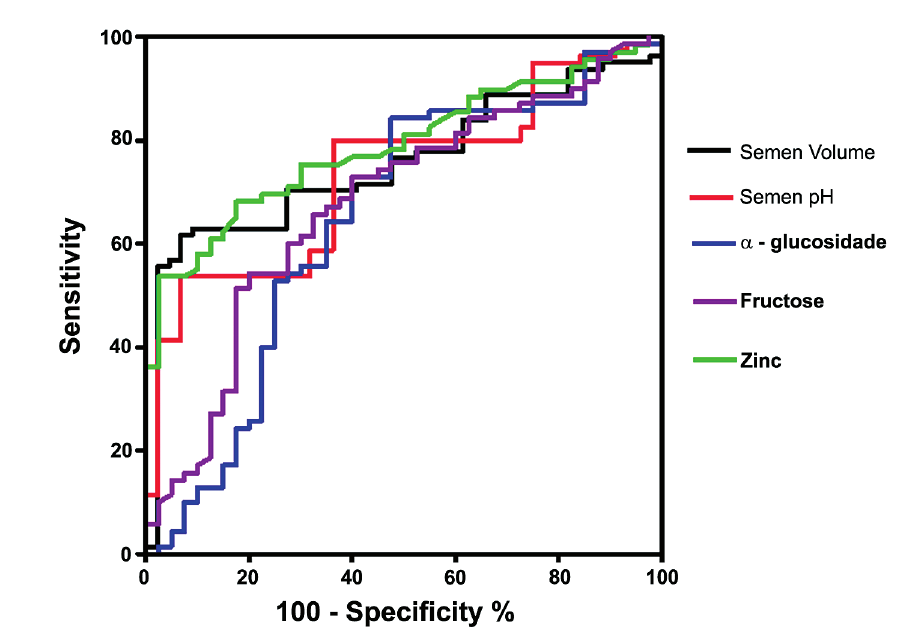
Figure 1 – ROCC analysis of semen volume, semen pH, alpha-glucosidase, fructose and zinc levels, to differentiate men with vs. without MRT infection. Semen volume = cut point 2.75 mL; sensitivity = 62.9%; specificity = 90.9%; AUC = 0.77. Semen pH = cut point 8.15; sensitivity = 58.8%, specificity = 63.6%, AUC = 0.67. Alpha-glucosidase: cut point 14.2 mU/ejaculate, sensitivity = 73%, specificity = 65%; AUC= 0.65. Fructose = cut point 47.5 µmol/ejaculate; sensitivity = 73.0%; specificity = 60.0%; AUC = 0.68. Zinc = cut point 14.2 U/ejaculate, sensitivity = 75.4%; specificity = 70.0%; AUC =